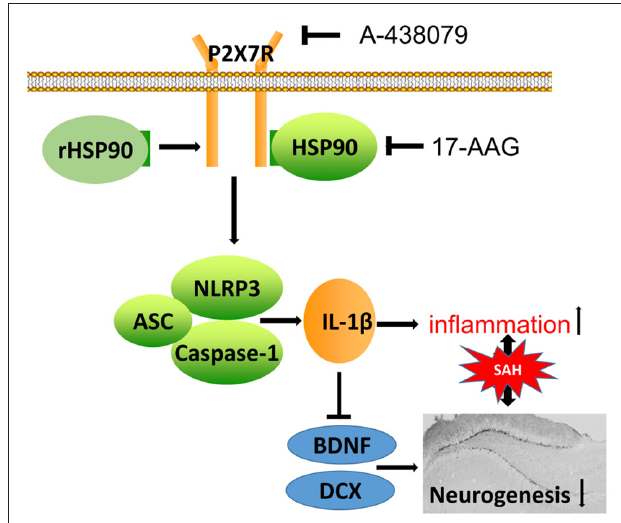
FIGURE 11 | Potential mechanistic pathway by which 17-AAG regulates inflammation and neurogenesis after SAH. SAH damage causes HSP90 upregulation, which leads to P2X7R activation and stimulates NLRP3 inflammasome assembly. The resultant maturation of IL-1 β is responsible for the inflammation and reparative neurogenesis. 17-AAG inhibits HSP90, resulting in attenuated inflammation and increased